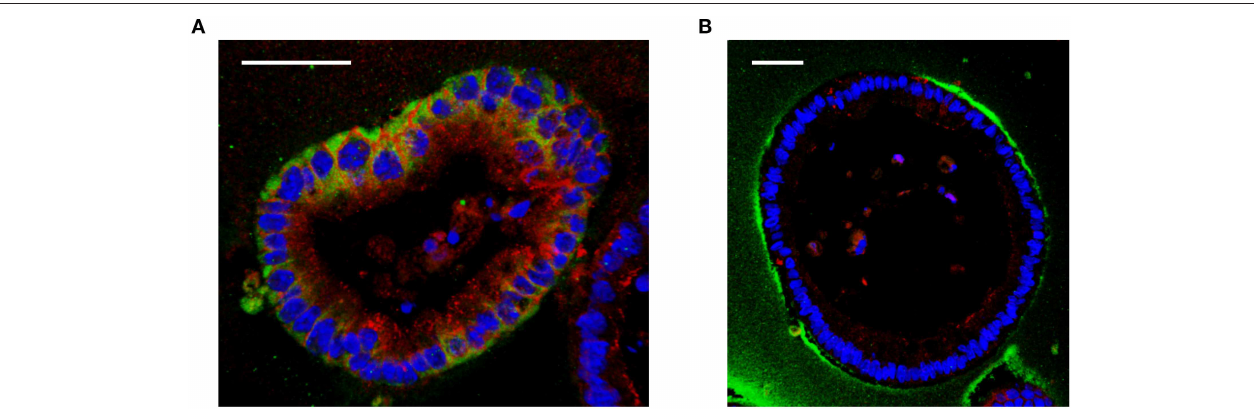
FIGURE 1 | Effect of different sizes of HA on cultured mouse intestinal organoids. (A) Immunofluorescent staining of HA 35 kDa (350 micrograms/ml, 30h) treated mouse intestinal organoids show internalized HA ( green ) and increased ZO-1 expression ( red ) compared to (B) HA2000 kDa (350 micrograms/ml, 30h) treated mouse intestinal organoids, which show no uptake of HA ( green ). DAPI = blue. Scale bar = 50mm. Immunohistochemical staining for HA was performed using biotinylated HA binding protein. Z-stack images were obtained using confocal microscopy and 3D images were generated using Velocity.